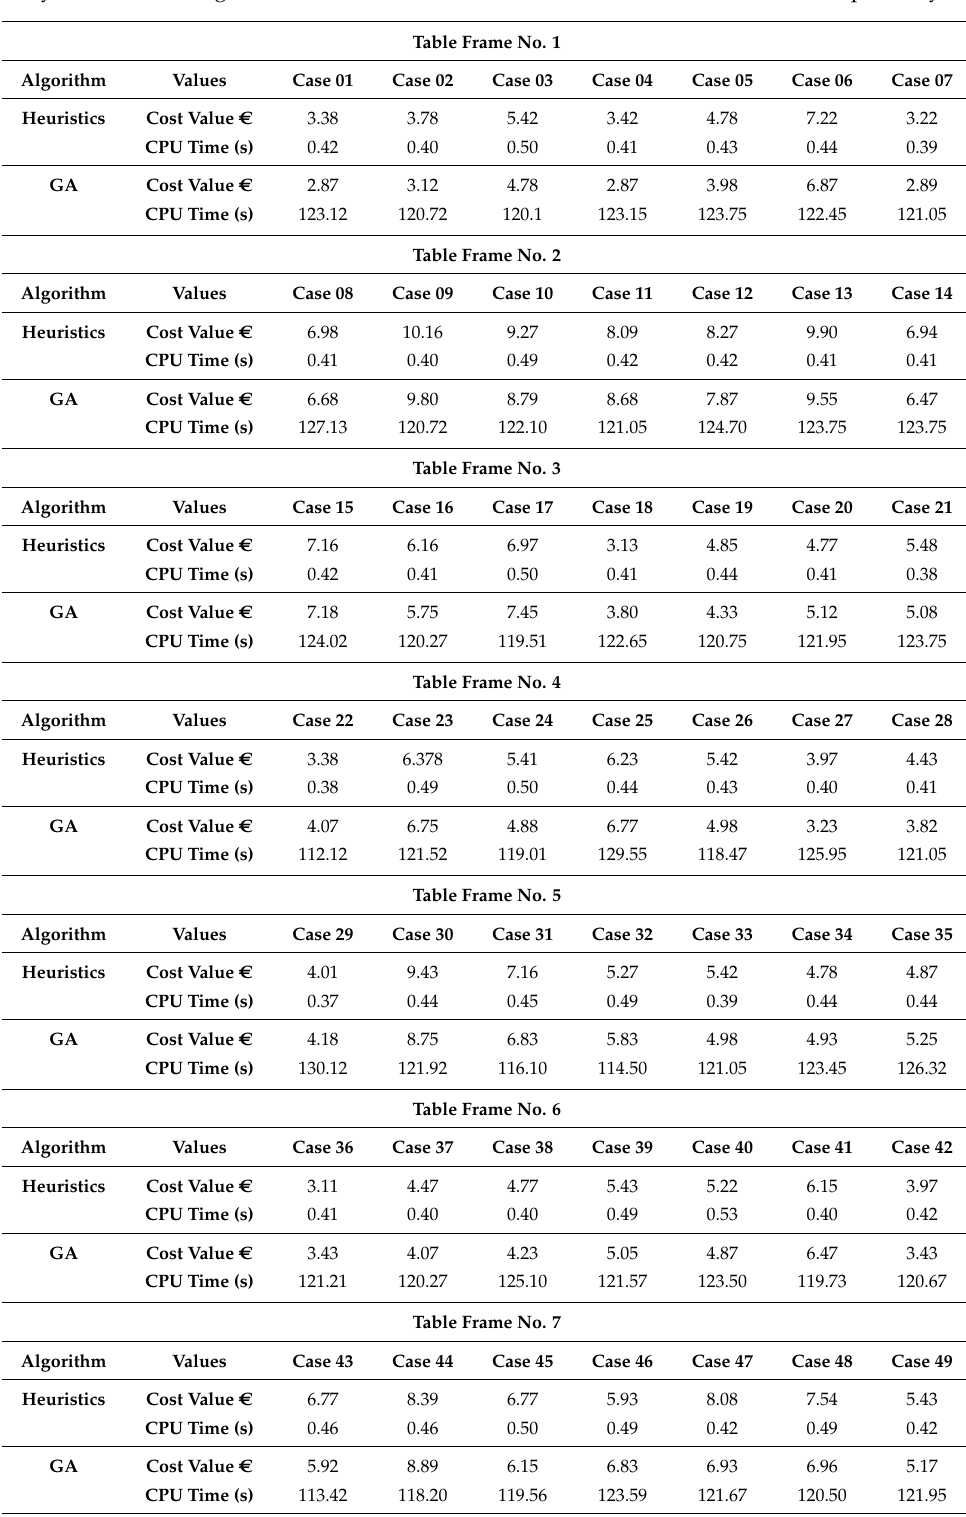
Table 4. Heuristics and GA test runs comparison. The CHP unit, the HP, and the thermal stor- age operating ranges considered in the test runs are 5 [ kW ] , 4 [ kW ] , and 10 [ kWh ] , respectively. The average cost and the CPU time of the heuristics over 50 test runs are 6.48 A C, and 0.45 s, respec- tively, while the average cost and the CPU time for the GA are 5.97 A C, and 127.15 s,